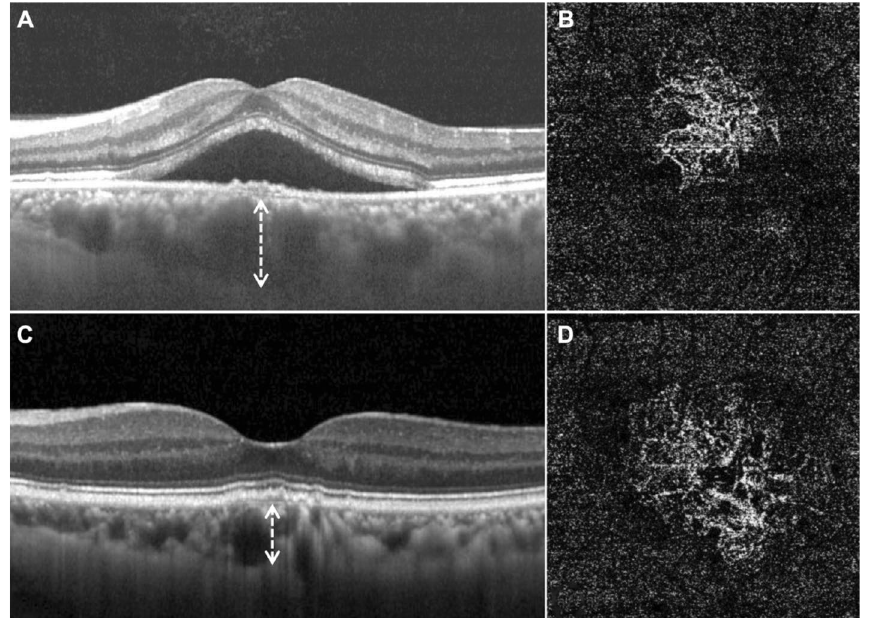
Figure 2. Representative OCT and OCTA images in the two groups. ( A ) and ( B ), Images of the left eye of a 58-year-old male with exudative PNV, who had a history of CSC. ( C ) and ( D ), Images of the left eye of a 66-year-old male with non-exudative PNV. ( A ) and ( C ), Exudative PNV has thicker choroid than non- exudative PNV (white dotted arrow, 422 μm, vs. 301 μm). ( B ) CNV image in DLS of exudative PNV. ( D ) CNV image in DLS of non-exudative PNV. Exudative PNV manifests higher vessel density. OCT, optical coherence tomography; OCTA, optical coherence tomography angiography; PNV, pachychoroid neovasculopathy; CNV, choroidal neovascularization; DLS, double layer